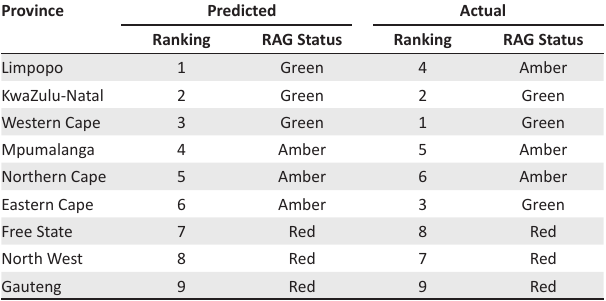
TABLE 8: Predicted ranks and Red, Amber or Green statuses resulting from the example payment behaviour model (using the specific model: Health Advanced Model 2 ) versus the actual ranks and